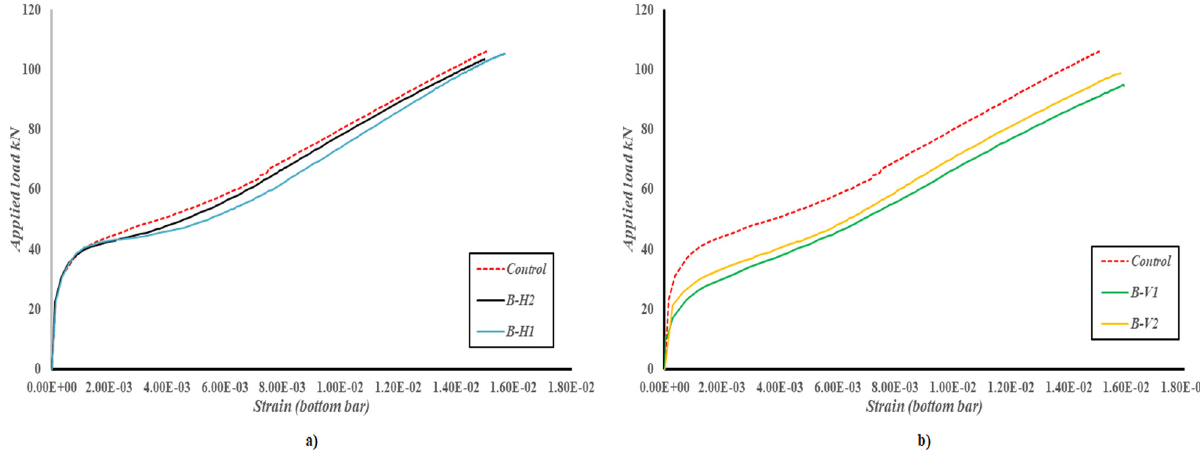
Figure 9: Load – main GFRP bars strain for the analyzed beams ( e ff ect of the number of openings ) . ( a ) Beams with horizontal openings and ( b ) beams with vertical